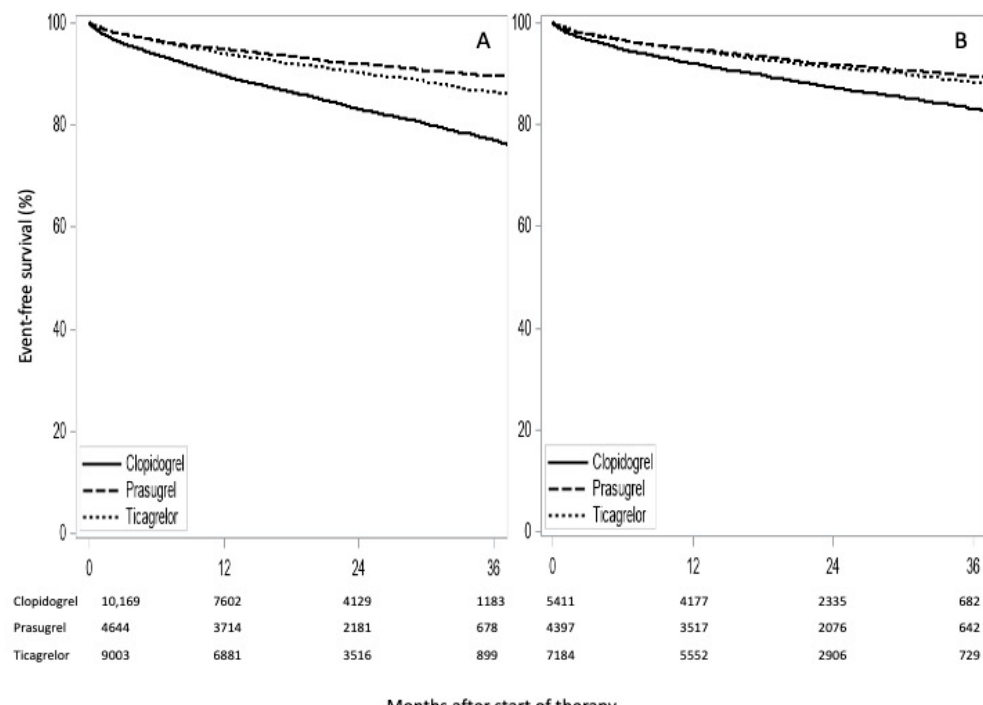
Figure 2. Event-free survival (recurrence of ACS or death) for all patients ( A ) and for patients aged ≤ 75 years ( B ) treated with clopidogrel, prasugrel, or ticagrelor. Numbers at risk are indicated. (A) p < 0.001 (log-rank test); (B) p < 0.001 (log-rank test). Adjusting for sex, age, their interaction, pre-existing medication, and calendar year as proxy for comorbidity (Table 3), the effect of medication on the composite endpoint was different when comparing the novel P2Y12 inhibitors (prasugrel and ticagrelor) with the standard P2Y12 inhibitor (clopidogrel), with a hazard ratio (HR) of 0.70 (95% CI: 0.61; 0.79) for prasugrel vs. clopidogrel and 0.70 (95% CI: 0.64; 0.77) for ticagrelor vs. clopidogrel. A re-parameterization of the adjusted model allows clopidogrel and prasugrel to be compared with ticagrelor, and results in an HR 1.76 (95% CI 1.62; 1.91) for clopidogrel vs. ticagrelor and 0.86 (95% CI 0.76; 0.97) for prasugrel vs. ticagrelor. Table 3. Predictors of recurrence of ACS or death.